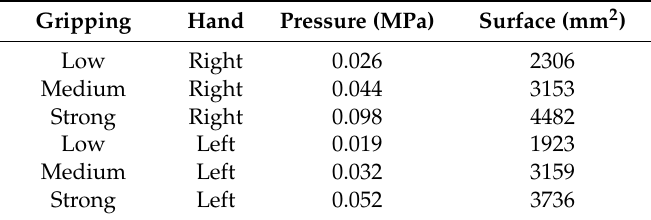
Table 3. Identification of modal data. The deformed shapes correspond to bending. The results are expressed in Frequency-Hz (Damping-%). (-) corresponds to an undefined value.